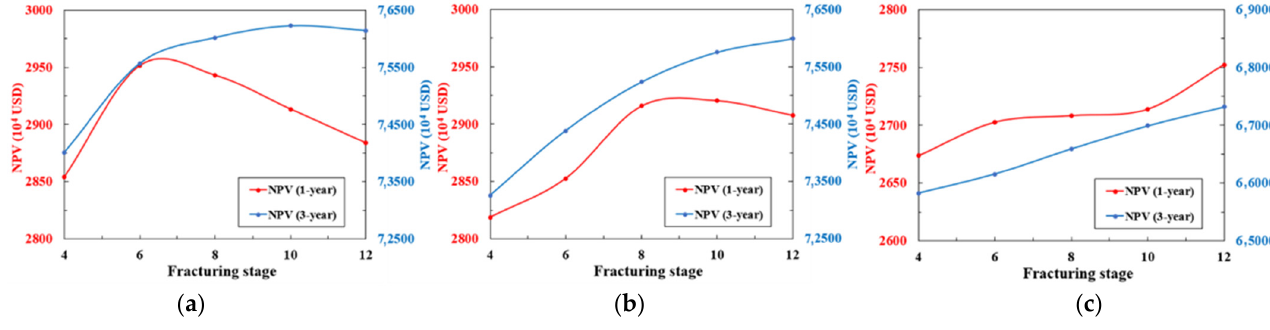
Figure 11. NPV of reservoir stimulation in ( a ) Type I, ( b ) Type II, ( c ) Type III.